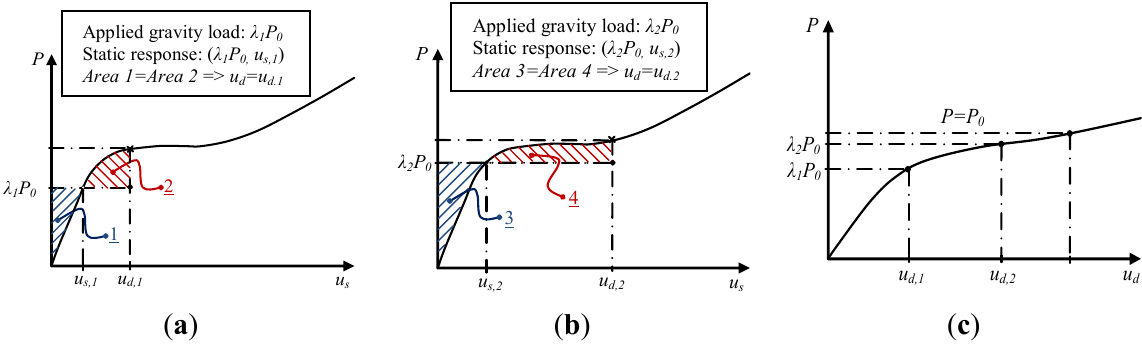
Figure 5. Static ( λ response at ( λ pseudo-static response.